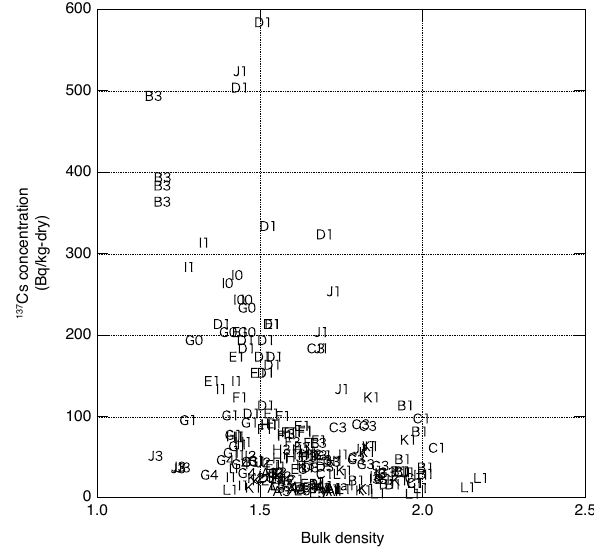
Fig. 8. Variation of 137 Cs inventory in sediments with 137 Cs con- centration in sediments at various sediment bulk densities.